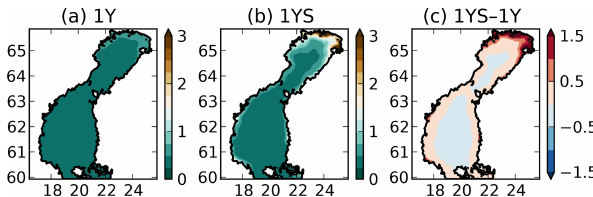
Figure 3. Modelled light extinction coefficient (m − 1 ) in the (a) 1Y and the (b) 1YS experiments and (c) the difference